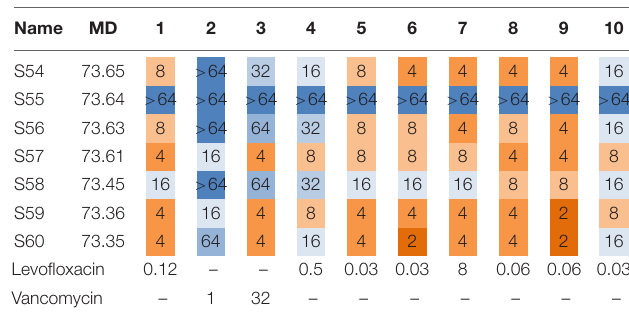
TABLE 1 | The antimicrobial activities of